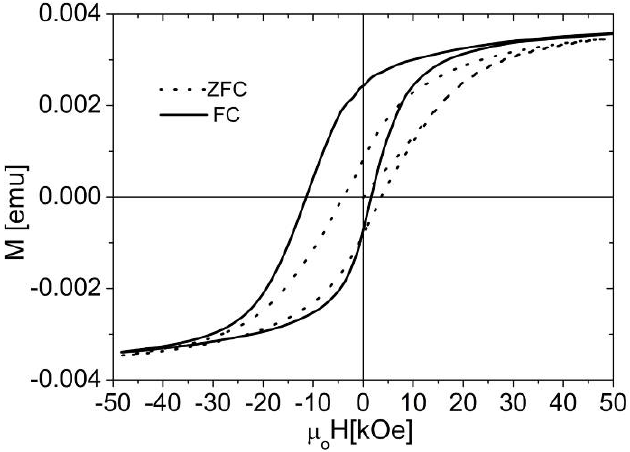
Figure 11. Hysteresis loops after Zero field Cooling (ZFC) and Field Cooling (FC, H = 5 T) at 2 K for the elastomer doped with 1 wt% Co. Before the measurement the sample has been heated during 5 min at 400